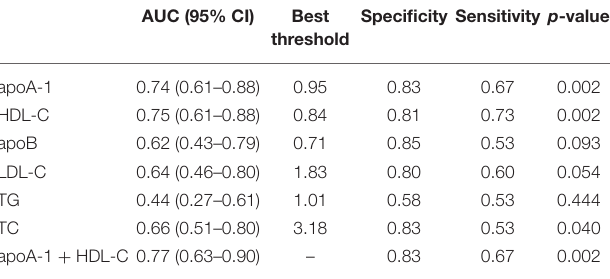
TABLE 4 | Diagnostic values of lipid profiles in assessment of COVID-19 mortality.